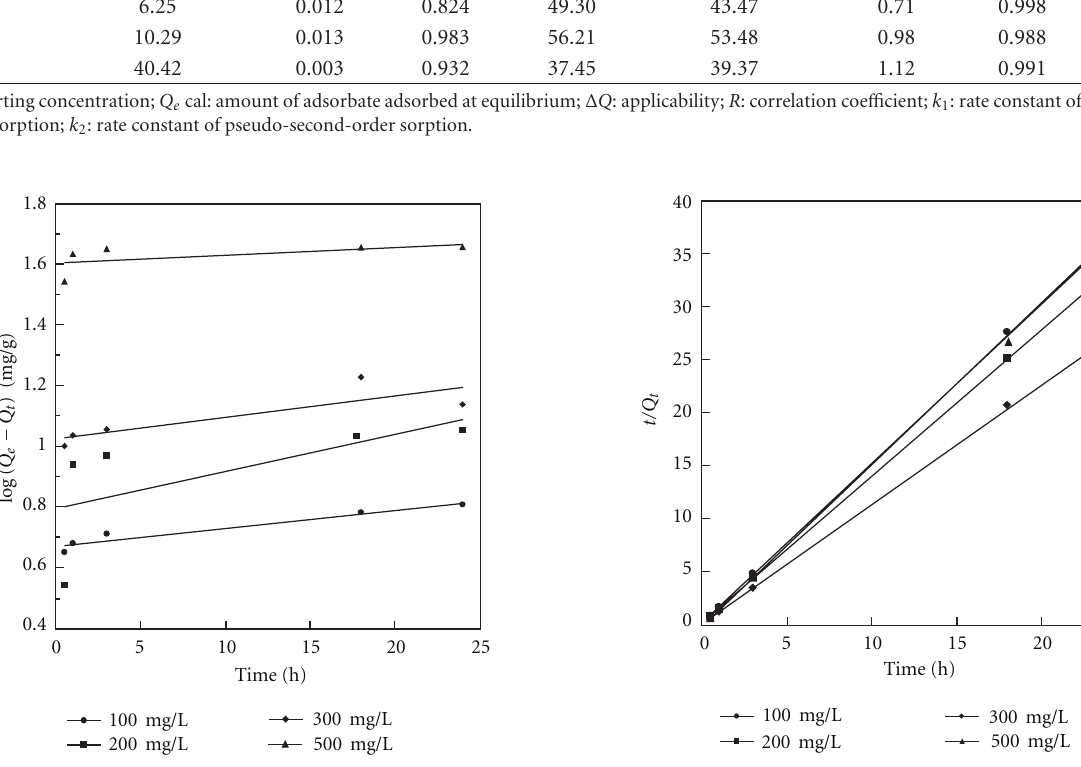
Figure 6: Pseudo second-order kinetics for adsorption of phenol onto BK at 25 ◦